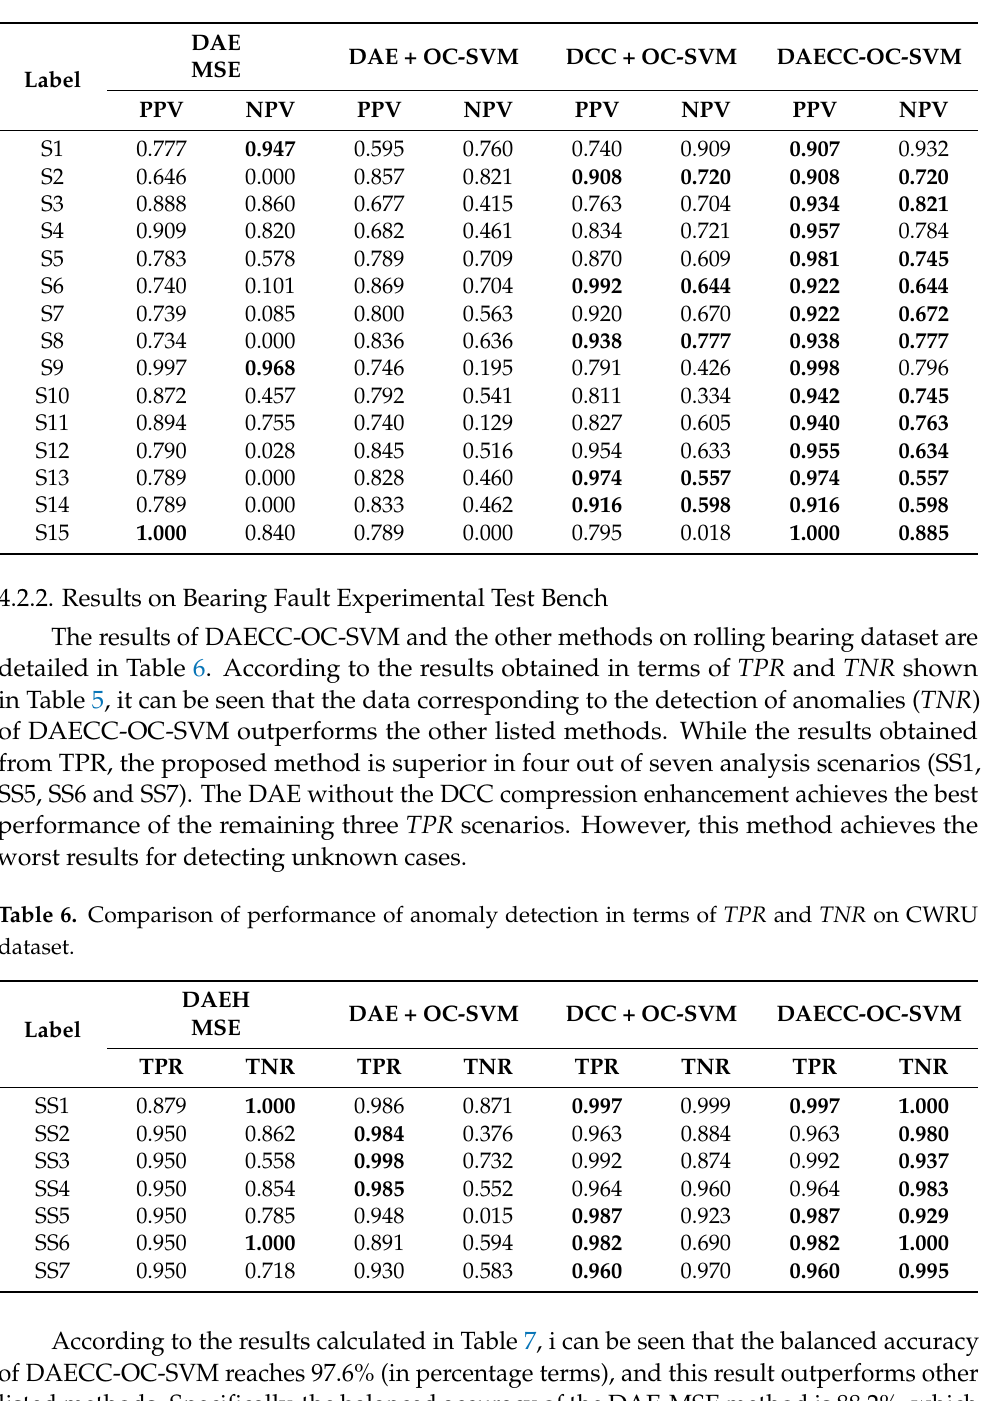
Table 5. Comparison of performance of anomaly detection in terms of PPV and NPV on the multi- fault test bench.